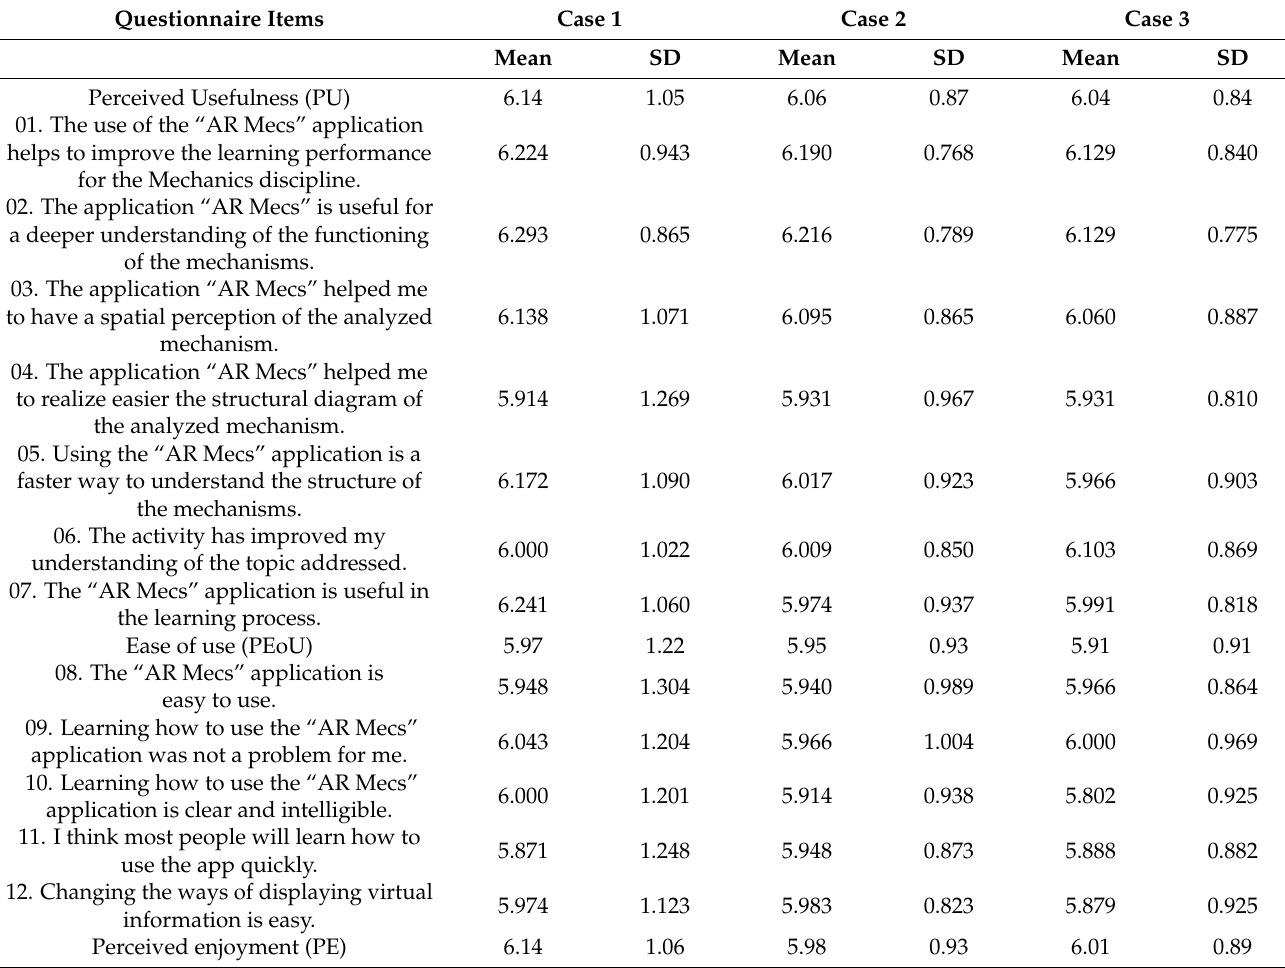
Table 5. The questionnaire statements and the mean values and standard deviations of the answers for each